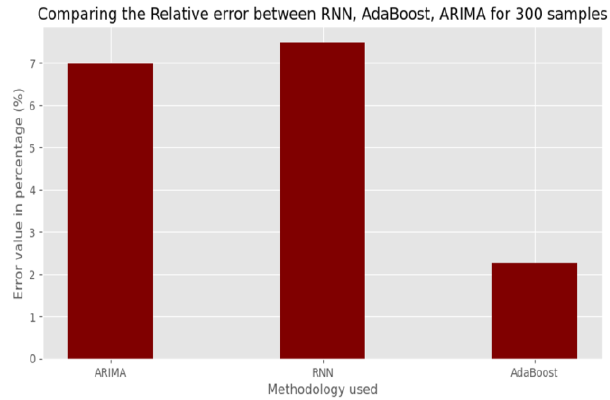
Figure 17. Comparing the Relative error between RNN, AdaBoost, ARIMA for 300 samples.